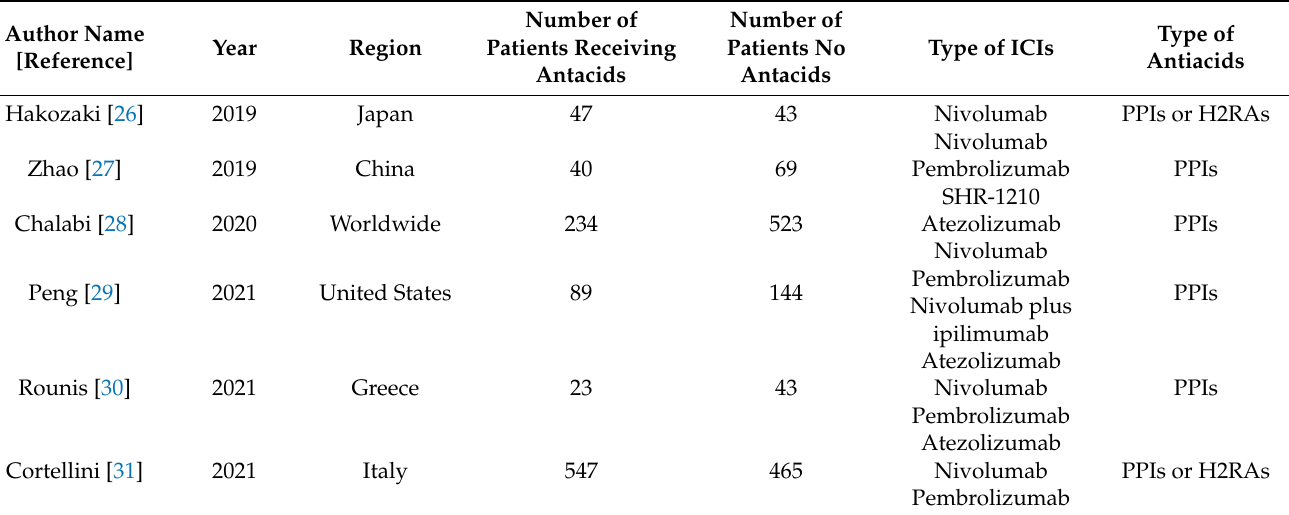
Table 1. Summary of all the included studies in the present